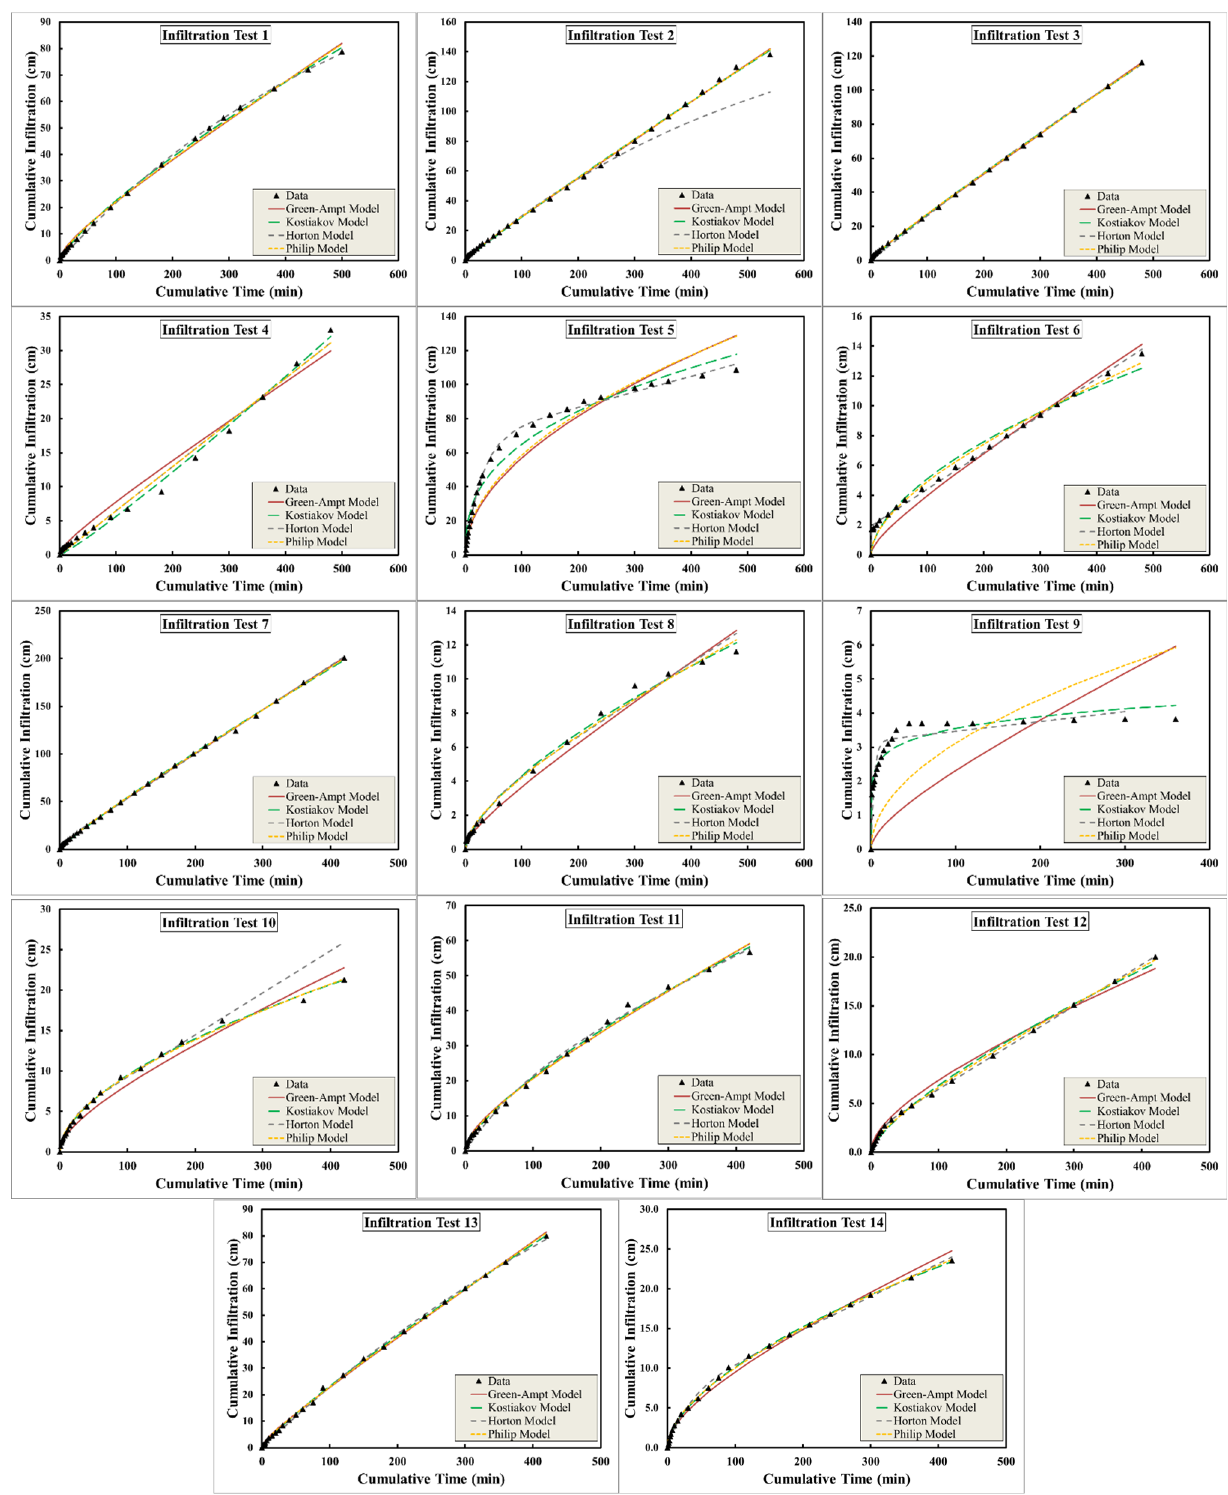
Figure 8. Field-measured cumulative infiltration depth versus modeled cumulative infiltration depth with the various